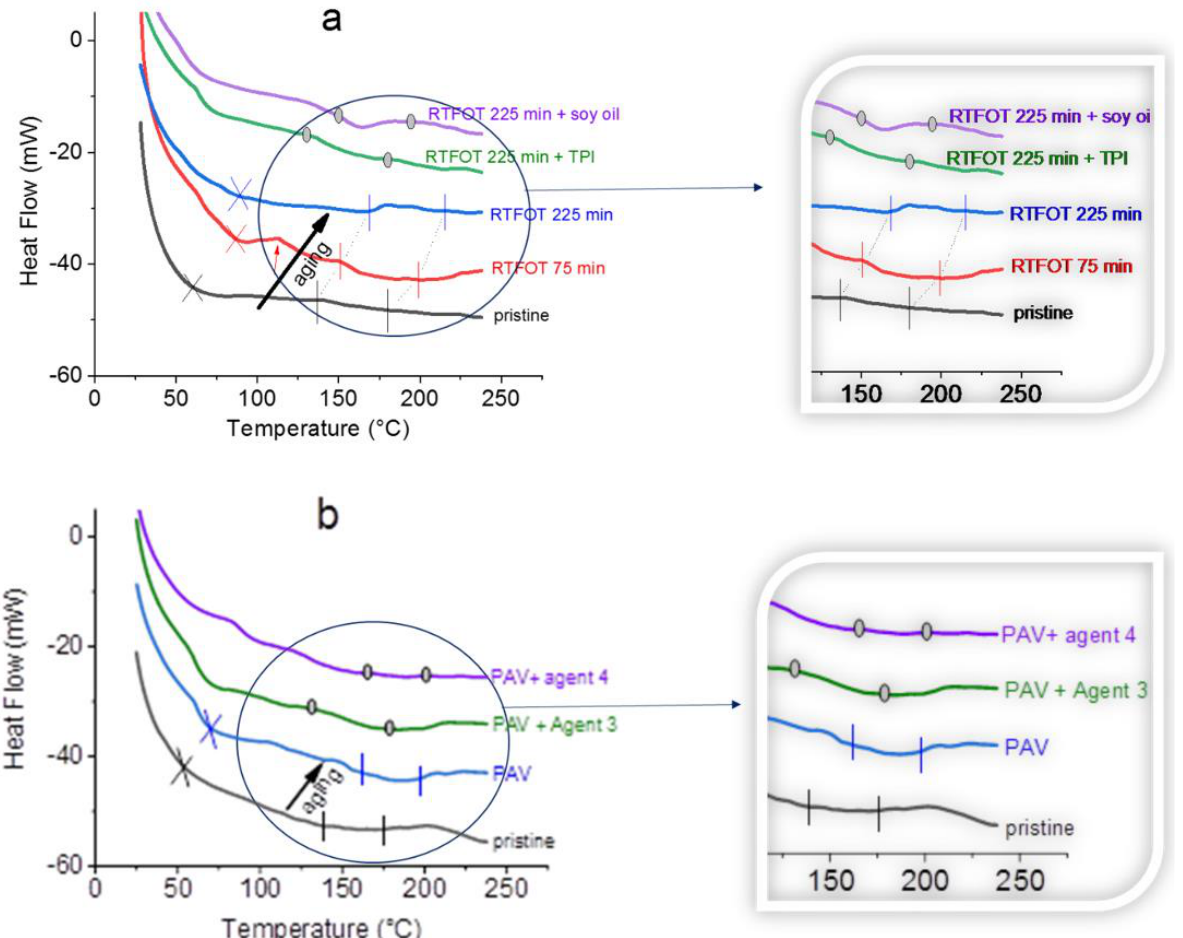
Figure 1. ( a ) DSC of asphaltenes bitumen Type 1 Non-Aged, RTFOT 75 and 225 min, showing the effect of aging, as compared to the RTFOT 225 after addition of TPI and Soy Oil; ( b ) DSC of asphaltenes bitumen Type 2 Non-Aged and PAV aged, as compared to the PAV aged after addition of Agent 3 and 4.